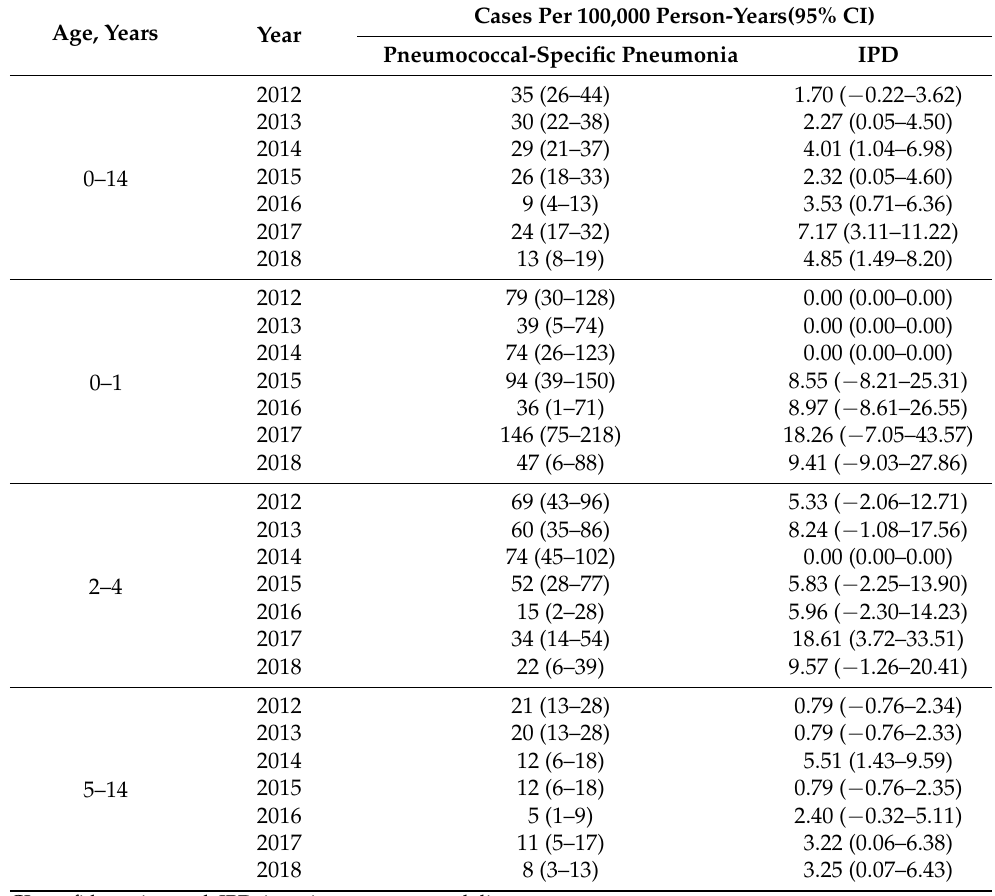
Table 3. Annual hospitalisation for pneumococcal-specific pneumonia and IPD between 2012–2018, by age cohort.